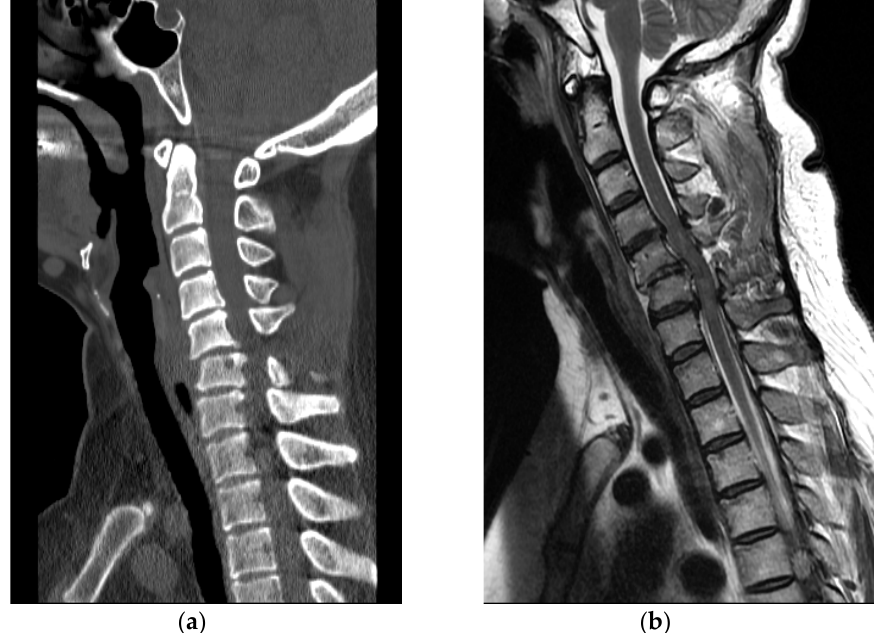
Figure 4. ( a ) Cervical spine CT revealed facet dislocation at C5-C6 and anterior displacement of the C5 vertebral body; ( b ) Cervical spine MRI showed cord compression with edematous cord signal change and an intramedullary hemorrhage.